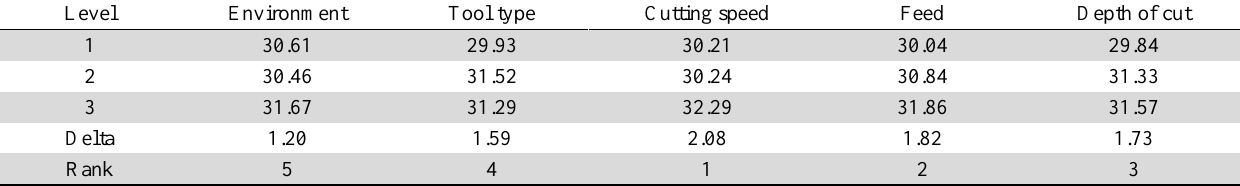
Response Table for Signal to Noise Ratios for Material Removal Rate (Larger is better) Level